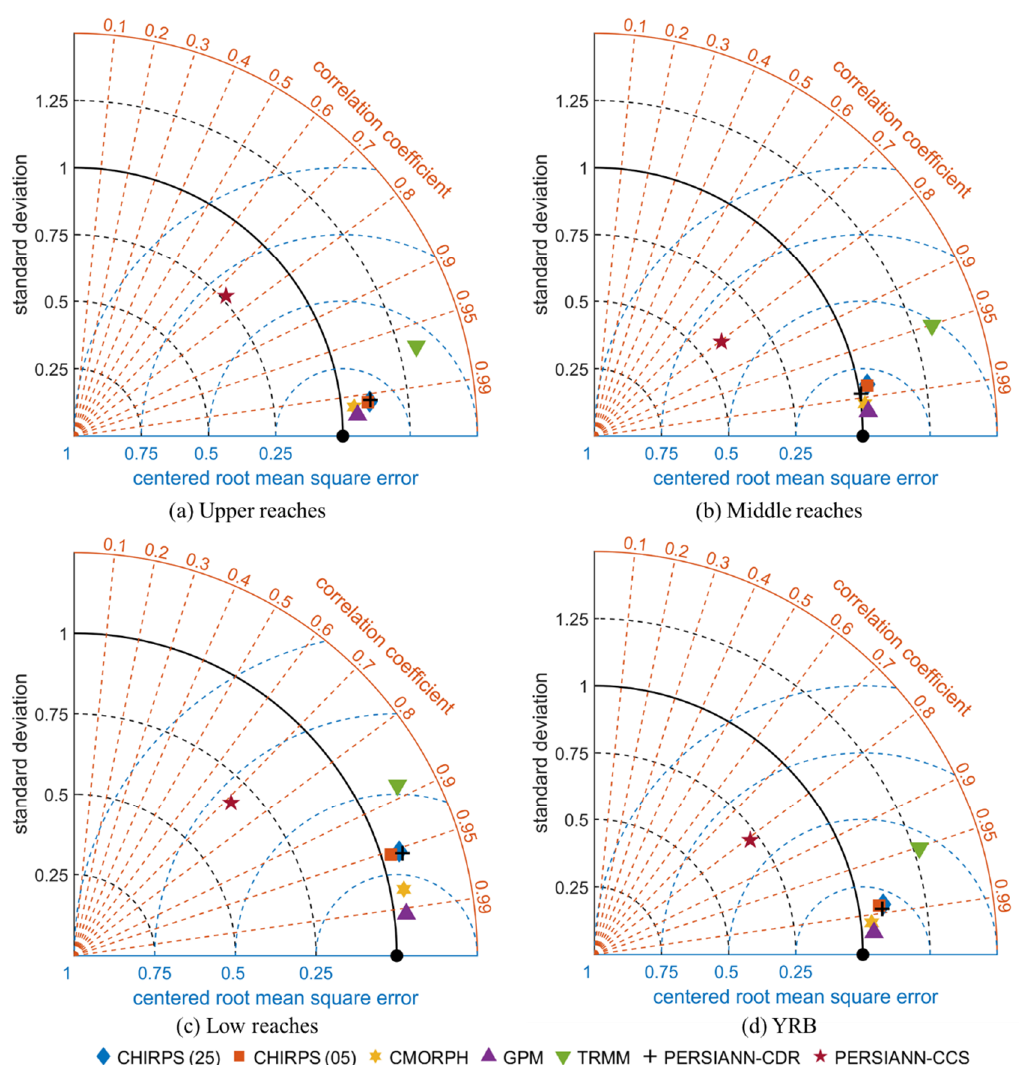
Figure 3. Taylor diagrams for monthly precipitation given by stations and SPPs.